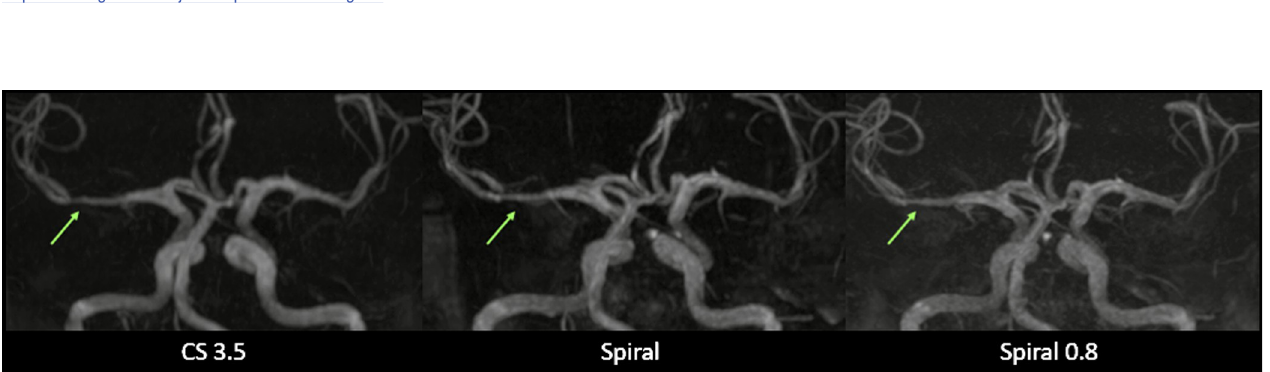
Fig 6. MIP images showing a tubular stenosis of the distal M1 segment of the middle cerebral artery.